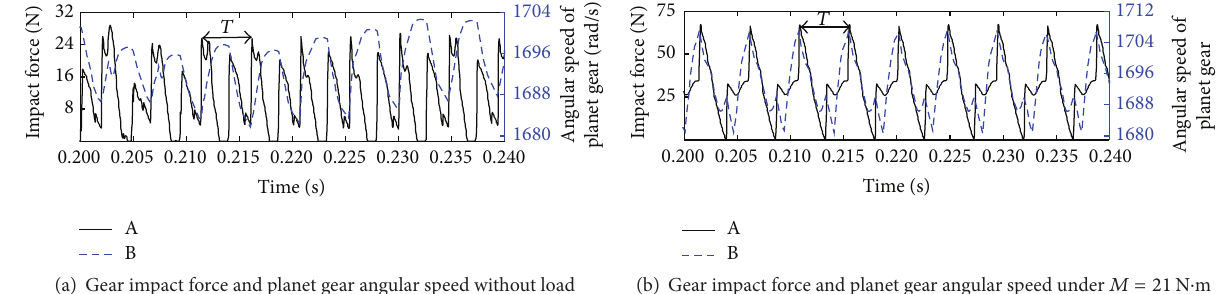
Figure 9: The dynamic impact force under different load.